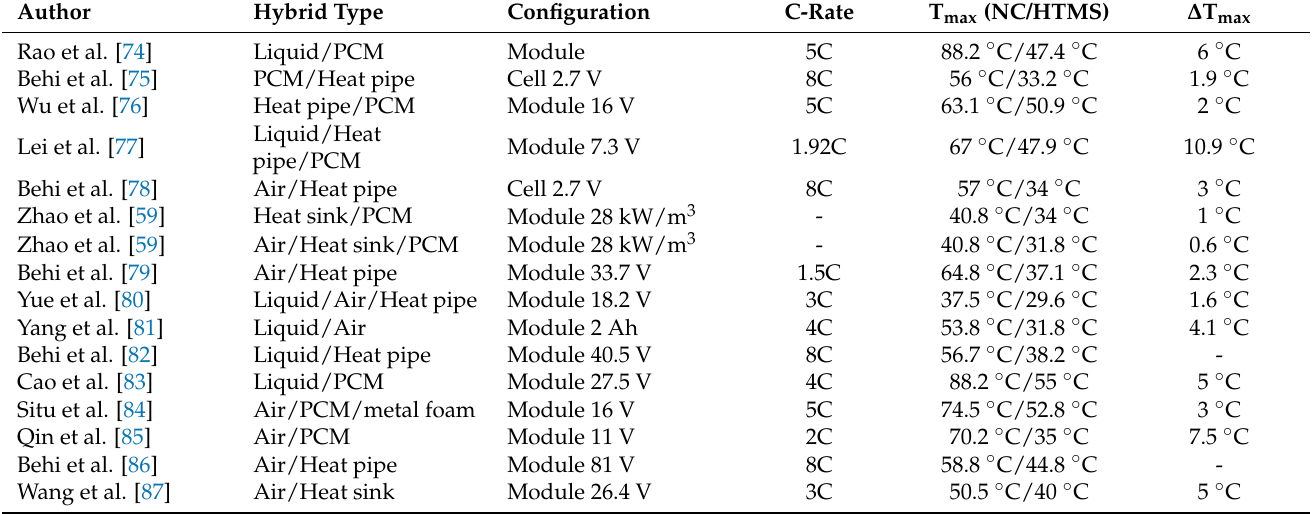
Table 2. Summary of the hybrid TMSs (HTMS) in the literature (NC means natural